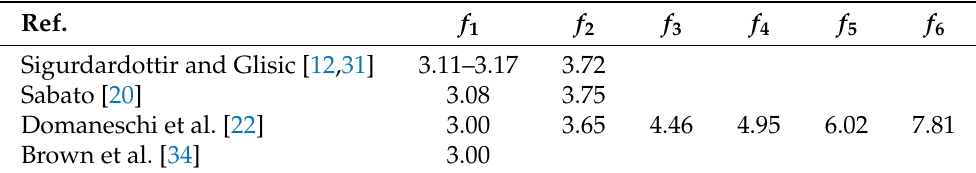
Table 2. Summary of identified natural frequencies